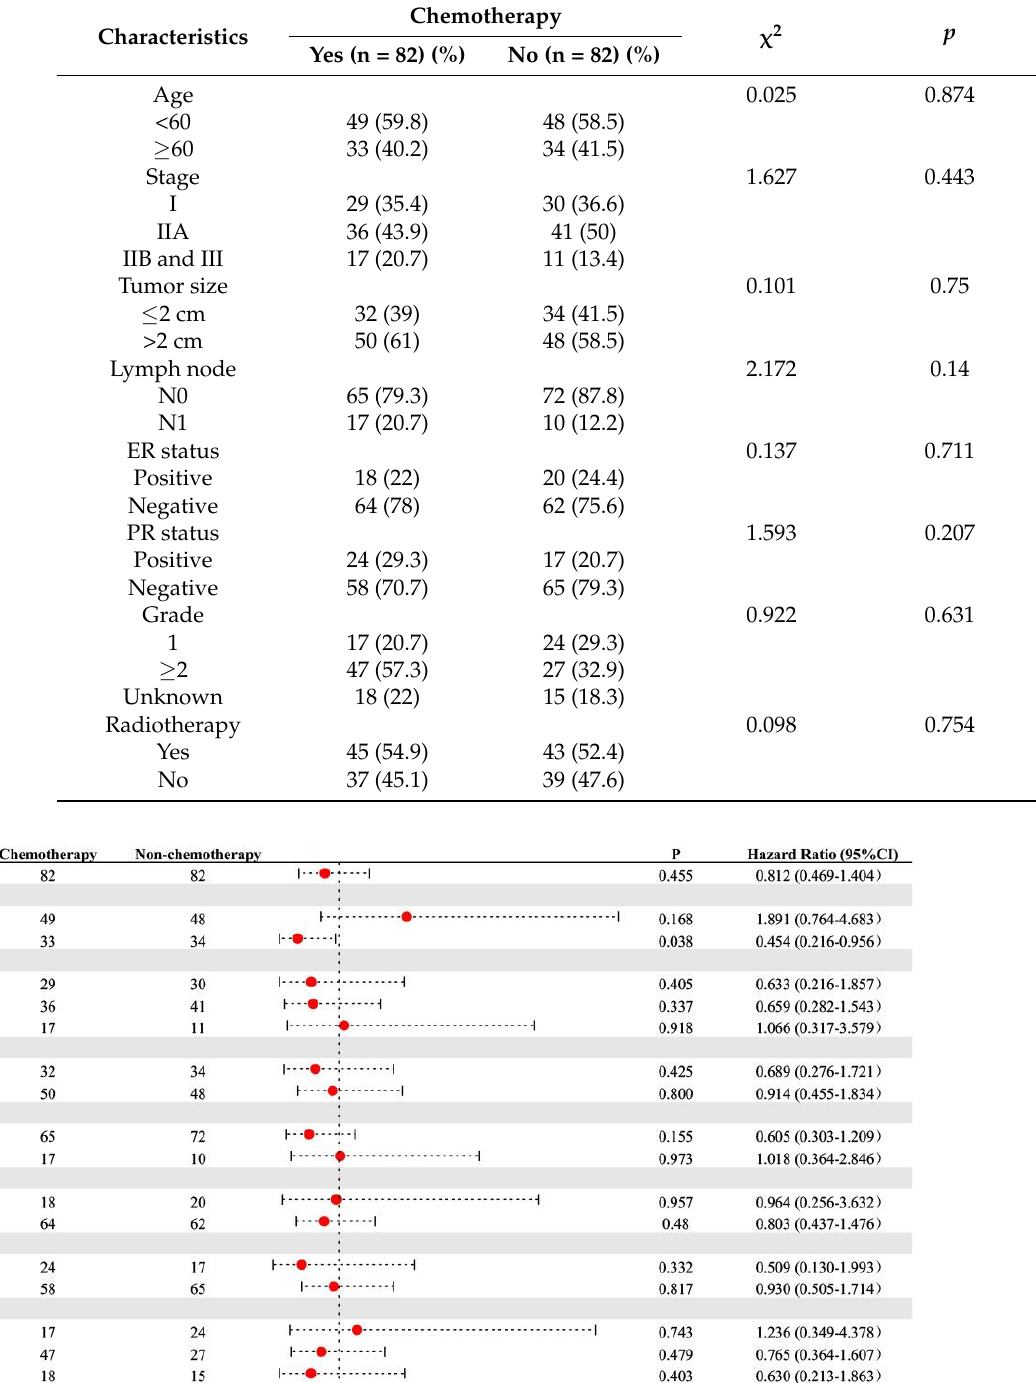
Table 3. Clinical characteristics of patients with ACCB in chemotherapy group and non-chemotherapy group after PSM in a 1:1 ratio.